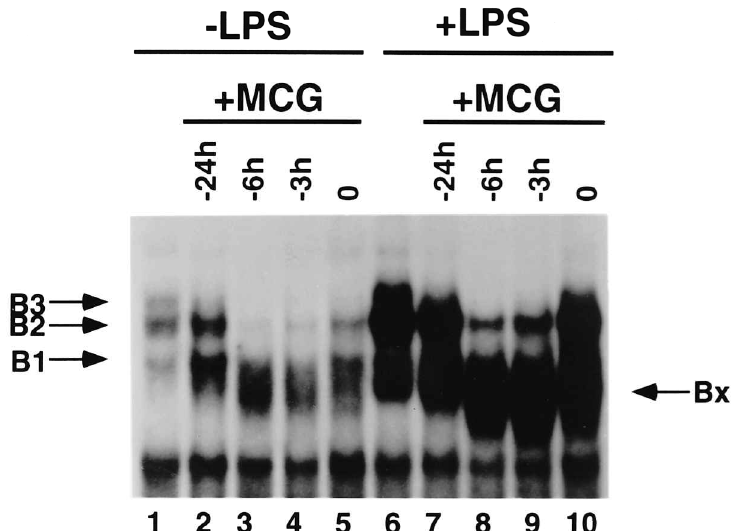
FIG. 5. Kinetics of generation of NF- k Bx proteins after phagocytosis of MCG. J774 cells were divided into 5 matched groups (lanes 1 to 10). They were cultured without MCG (lanes 1 and 6) or with MCG for 24h (lanes 2 and 7), 6h (lanes 3 and 8), 3h (lanes 4 and 9) or 0h (lanes 5 and 10) at a macrophage to mast cell ratio of 5 to 1. One of each matched group of MCG-untreated (lane 6) or -treated cells (lanes 7 to 10) was then exposed for 30min to LPS (10ng/ml), whereas the other half was not. Thus, all groups of the cells were cultured for a total of 24.5h. After washing the cells, nuclear proteins were extracted from each group of cells and were subjected to EMSA using radiolabelled NF- k B oligonucleotide as ligand as described in the Experimental section. An additional experiment gave a similar result to that